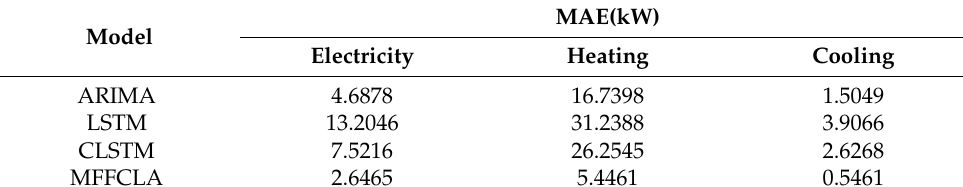
Table 4. MAE evaluation.